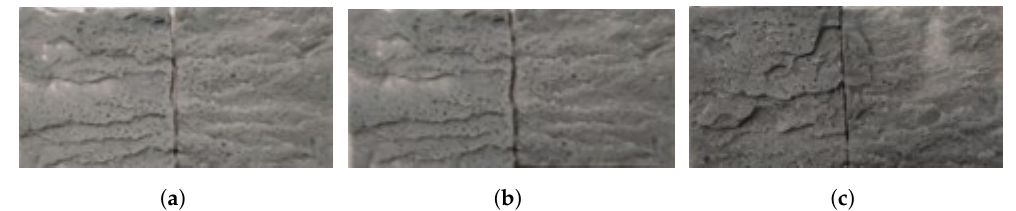
Figure 18. Fracture surfaces of dry joints with aluminum substrates with 0.5 mm ( a ), 1 mm ( b ), and 2 mm ( c ) of adhesive